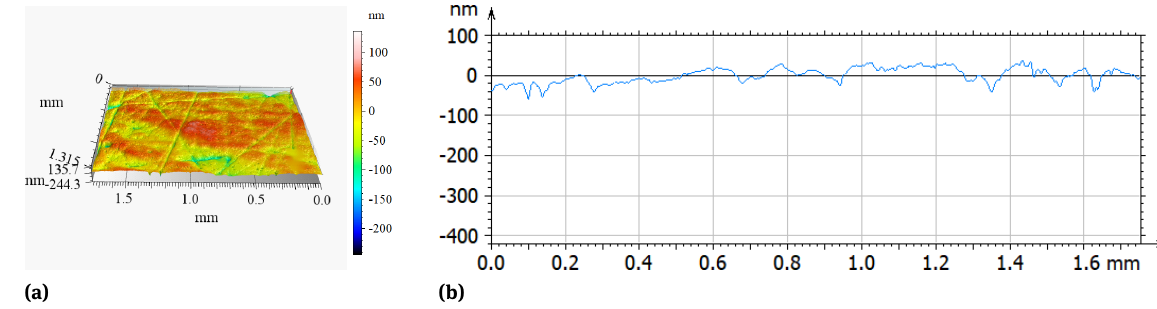
Figure 3: Geometric structure of 100Cr6 steel disk with the a–C:H coating: a) isometic image, b) primary profile.